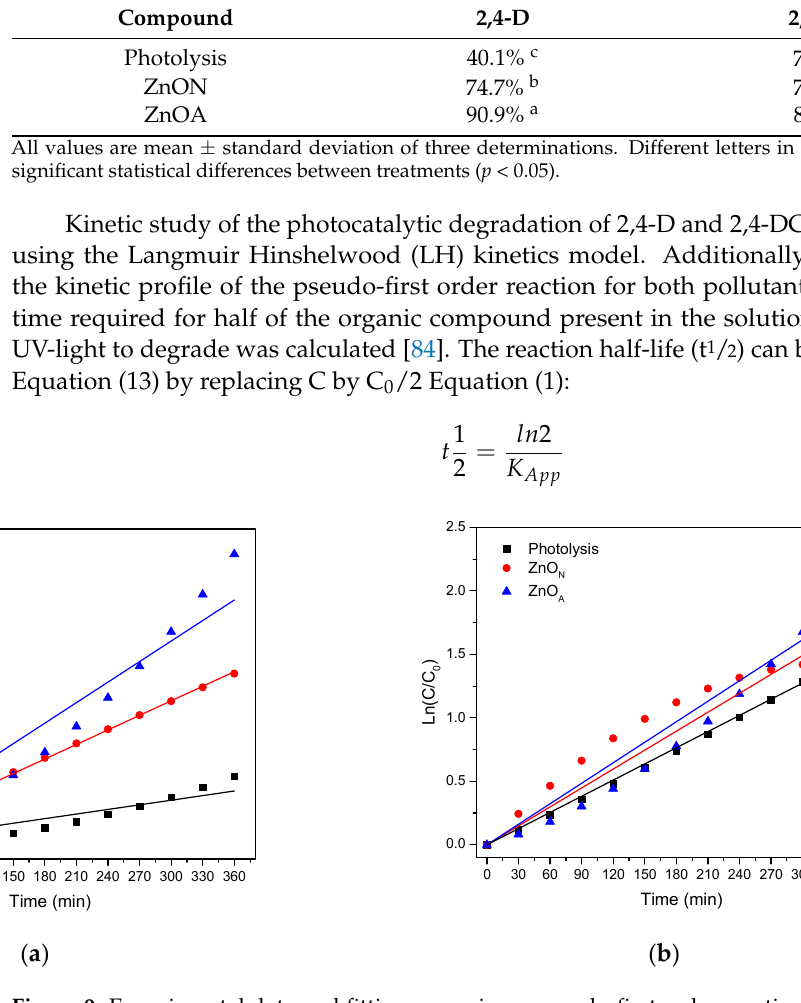
Figure 9. Experimental data and fitting assuming a pseudo-first order reaction rate: 2,4-D ( a ) and 2,4-DCP ( b ).